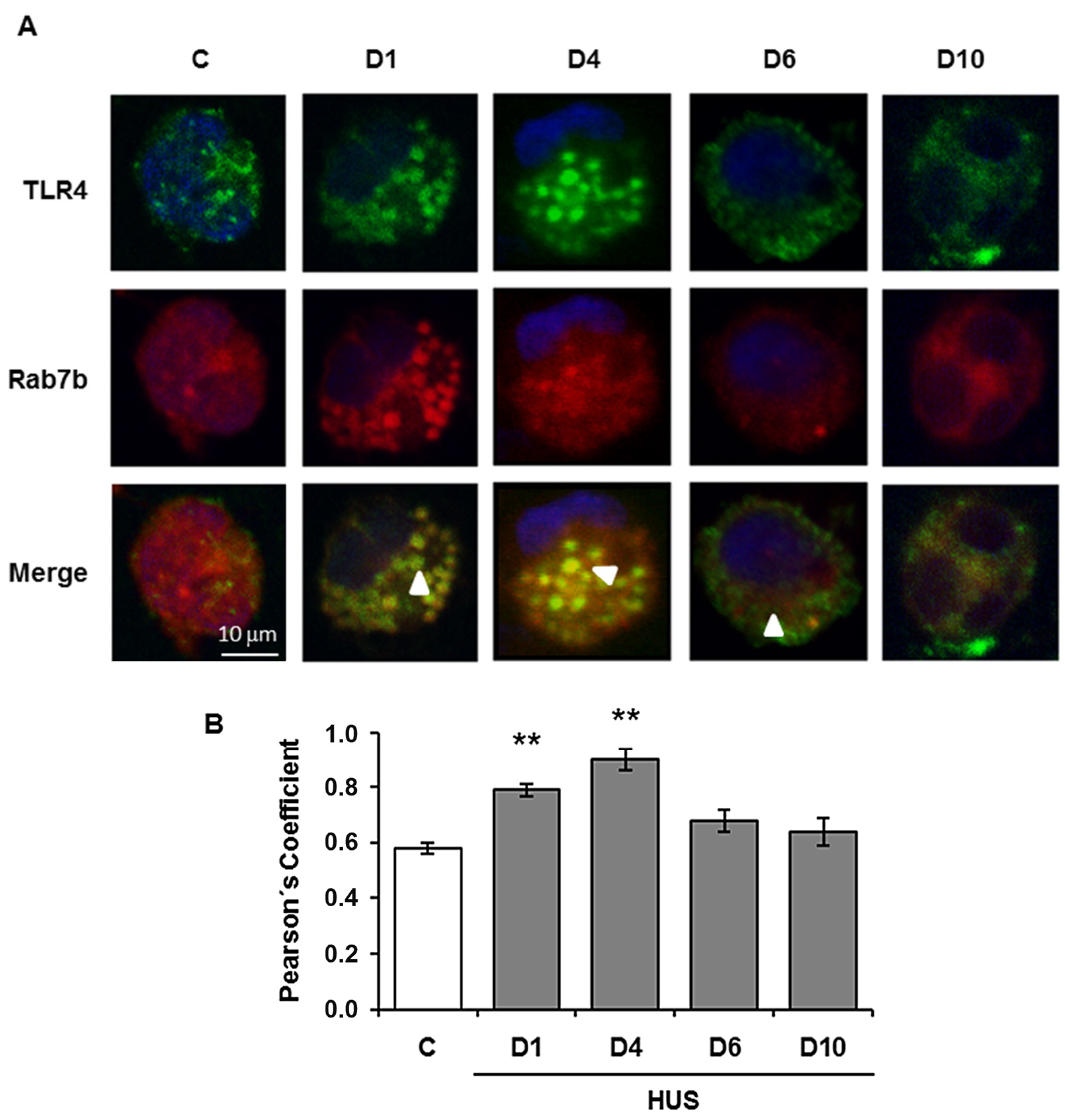
Figure 2. Colocalization analysis of Rab7b and TLR4 in monocytes during the acute course of STEC- HUS. TLR4 and Rab7b colocalization in monocytes was determined throughout the progression of HUS and in controls by indirect immunofluorescence and confocal microscopy. Specific rabbit anti TLR4/anti rabbit FITC (green), mouse anti Rab7b/anti mouse Cy3 (red), and Hoechst to visualize the nuclei (blue) were used. ( A ) representative immunofluorescence of both proteins in monocytes from one STEC-HUS patient and one control. The arrows indicate the colocalization areas. Scale bar 10 µ m. Magnification 600 × . ( B ). Graphic bar shows the TLR4 and Rab7b colocalization, which was deter- mined by using the Pearson’s Coefficient. ** p < 0.01 vs. control. 20 cells from 3 independent cultures were analyzed for each day of the STEC-HUS follow-up. In addition, 20 cells from 5 independent cultures in the control group were evaluated. Data are expressed as the mean ± SEM. (Adapted from reference [122]).